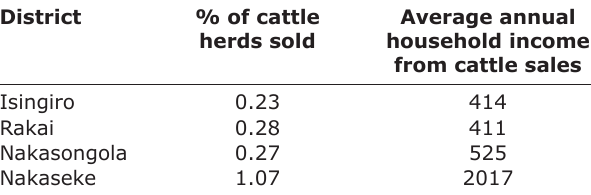
Table-6: The percentage of the cattle herd sold and average annual household income in US dollars earned from cattle sales per